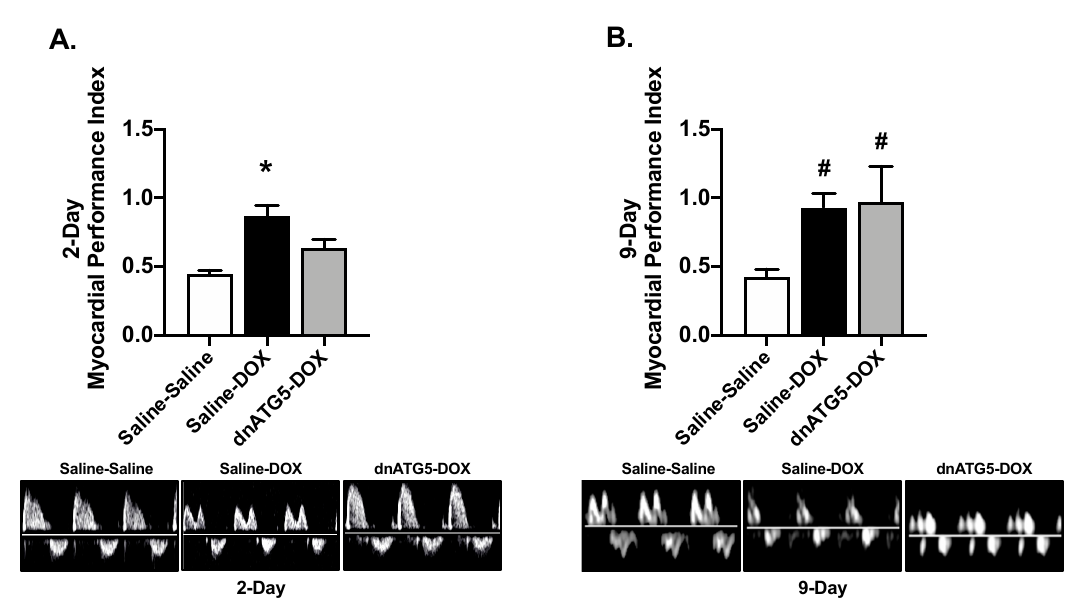
Figure 3. Myocardial performance index. Myocardial performance index was analyzed at the ( A ) 2-day and ( B ) 9-day timepoints. Representative doppler images are displayed below the graph for the 2-day and 9-day timepoints. Values are presented as means ± SEM, n = 5–8 / group. * significantly di ff erent versus all groups ( p < 0.05). # significantly di ff erent versus Saline-Saline ( p < 0.05). Table 2. Di ff erences in cardiac left ventricle septal and posterior wall thickness among experimental groups. Saline-Saline Saline-DOX dnATG5-DOX